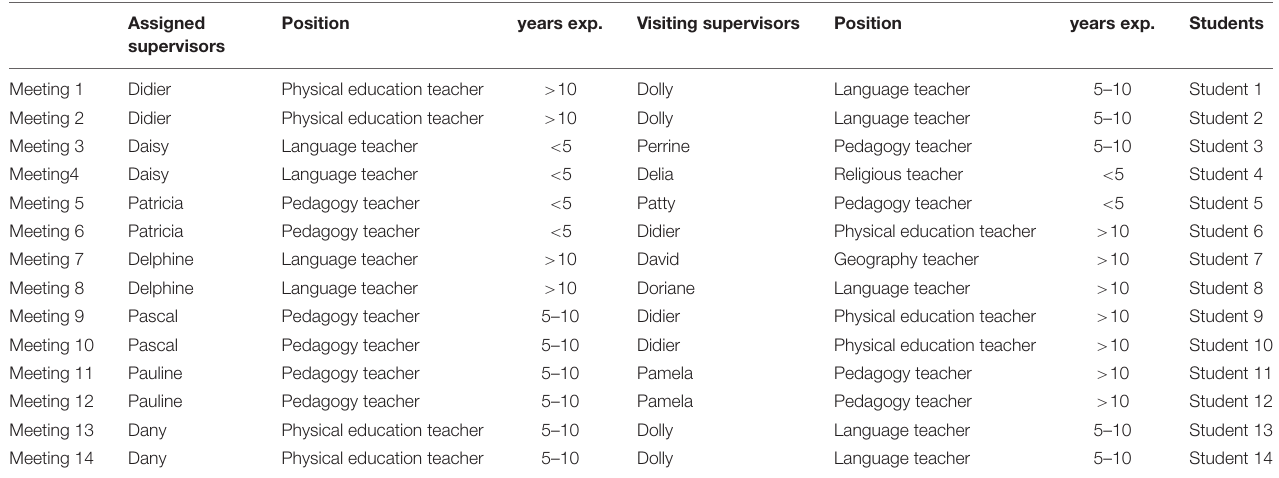
FIGURE 1 | Details of the internship supervision process. TABLE 1 | Participant